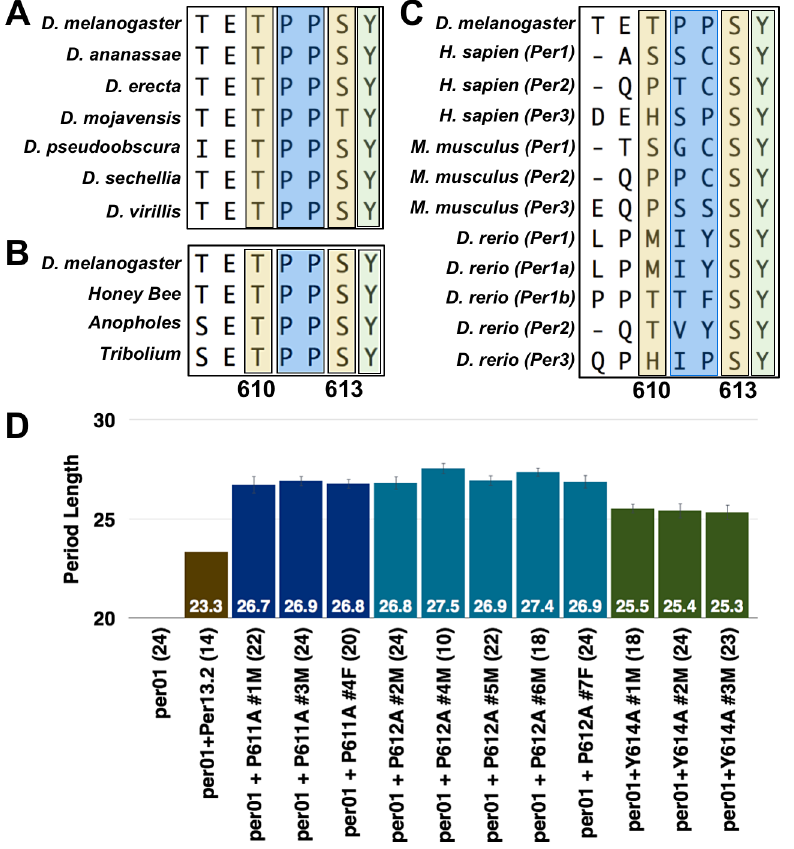
Figure 4. S613 is conserved throughout evolution. PER protein sequence alignment with various ( A ) Drosophila , ( B ) insect, and ( C ) vertebrate species. Alignments were generated using the Clustal-W Method within the MegAlign program contained in the DNA Star software package. Alignment Reports were exported and cropped to highlight the indicated residue stretches. Note the evolutionary conservation of the S613 (second yellow box) and Y614 (green box) residues; prolines are highlighted in a blue box. ( D ) Graphs depicting period length of a wild type transgenic fly line (brown bar) or those harboring the P611A (dark blue bars), P612A (light blue bars), or Y614A (green bars) mutations. Data from all transgenic lines are shown. Period lengths are listed within each bar and values in parentheses indicate the number of flies analyzed. Raw data are summarized in Table 1. Only male flies were analyzed in these experiments.